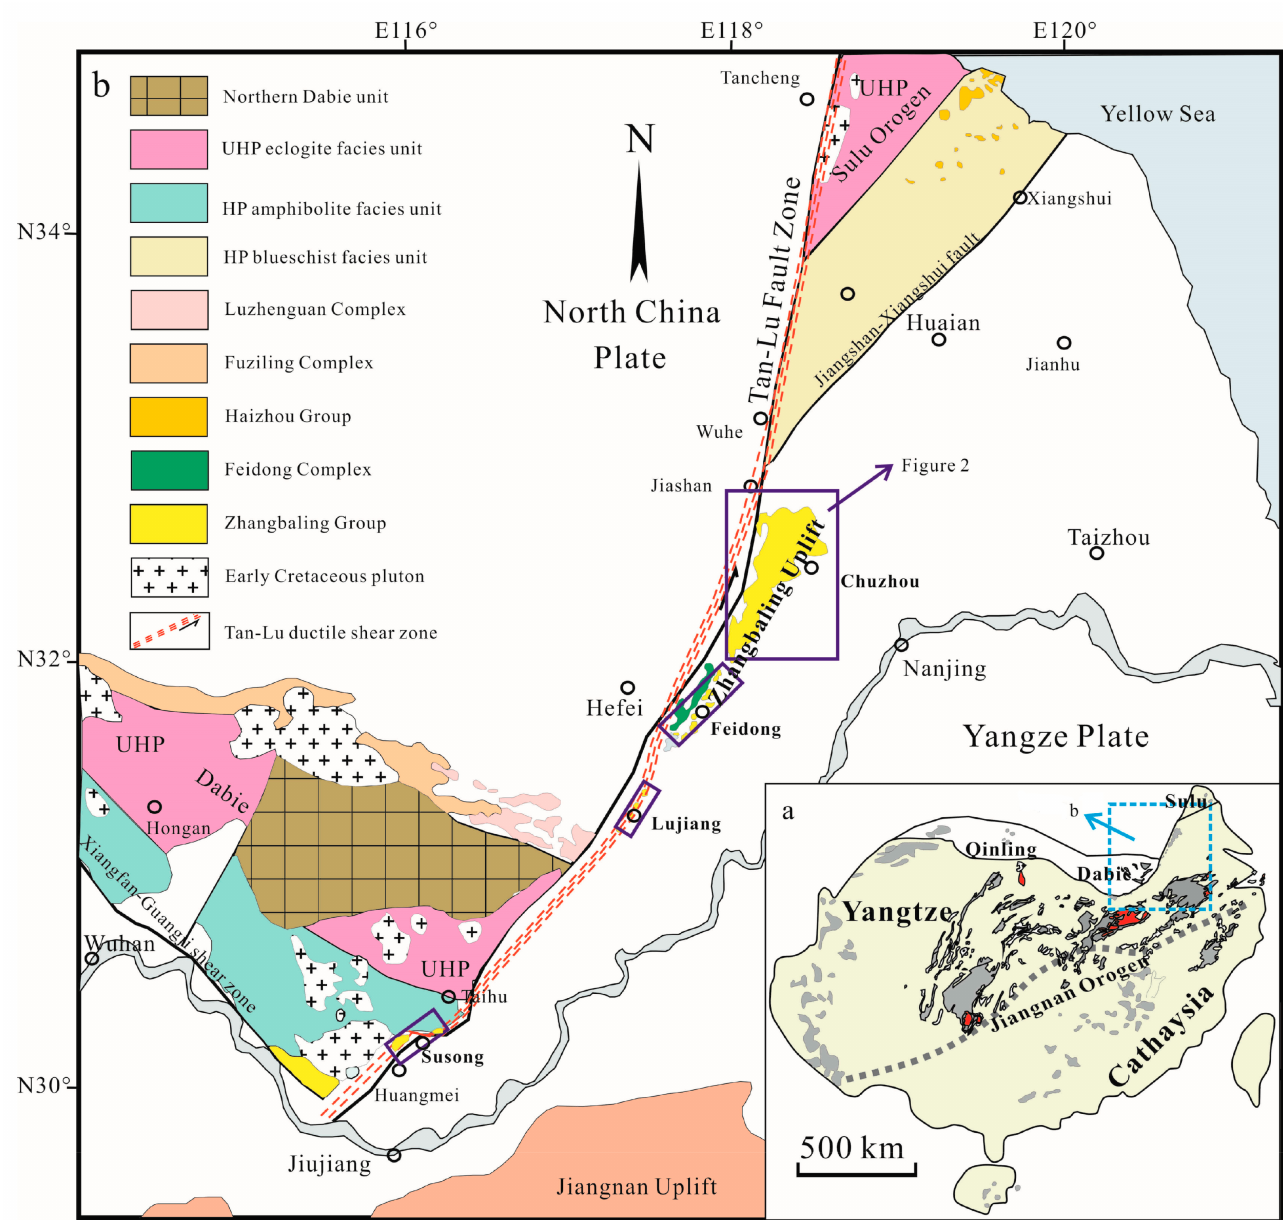
Figure 1. ( a ) Sketch map of the Sorth China Plate; ( b ) Simplified geological map in the southern Tan-Lu fault zone after [17]. HP: high pressure; UHP: ultra-high